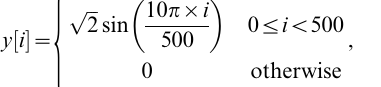
Figure 2. verifies the correctness of the variance of PRVCC, by plotting the simulation results (circles) and the theoretical results of (22) (solid lines) concerning V ( r H ) in the same scenarios as in Figure 1. For the purpose of comparison, the contamination-free version (50) (dashed lines) is also included in each subplot to highlight the effects of r ’ and e . Note that we have multiplied V (